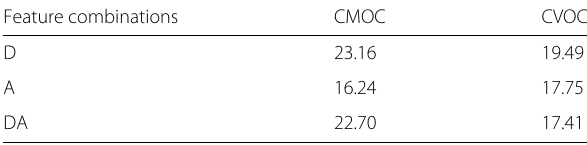
development set using dynamic features of CMOC and CVOC Feature